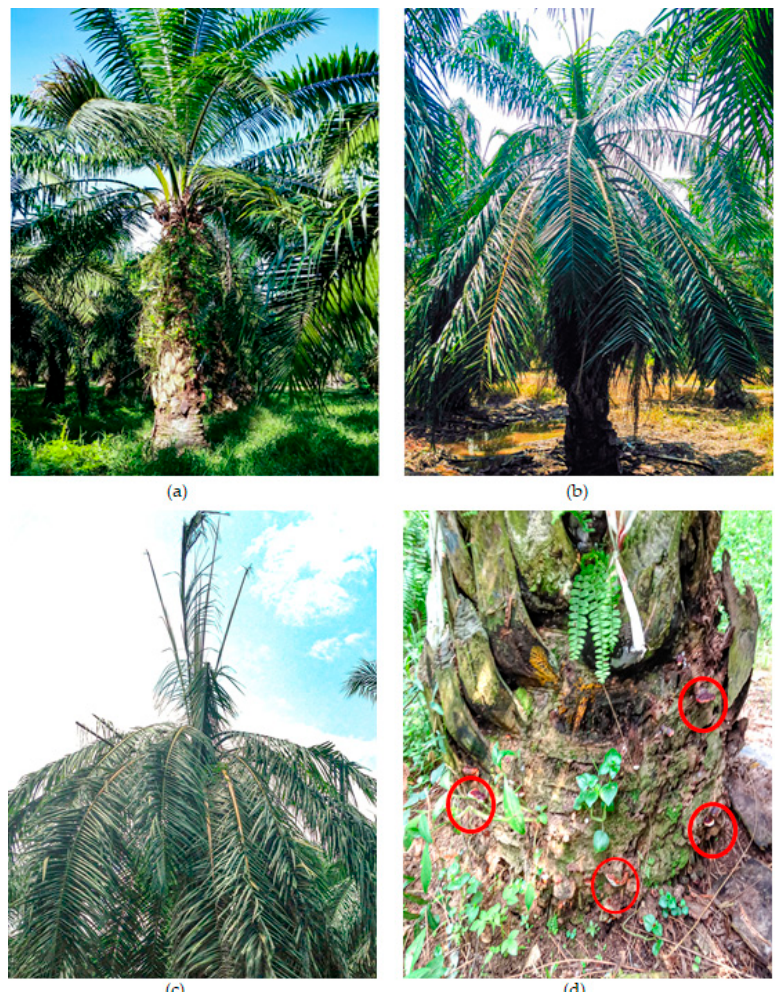
Figure 2. Oil palm trees in Felcra Seberang Perak 10, Phase 1, Parcel 3—( a ) tree non-infected by G. boninense ; ( b ) tree infected by G. boninense : showing foliar symptom such as the lower parts of leaves have formed like skirting; ( c ) tree infected by G. boninense : showing multiple unopened spears; ( d ) tree infected by G. boninense : showing the fruiting bodies and decay of the palm bole.